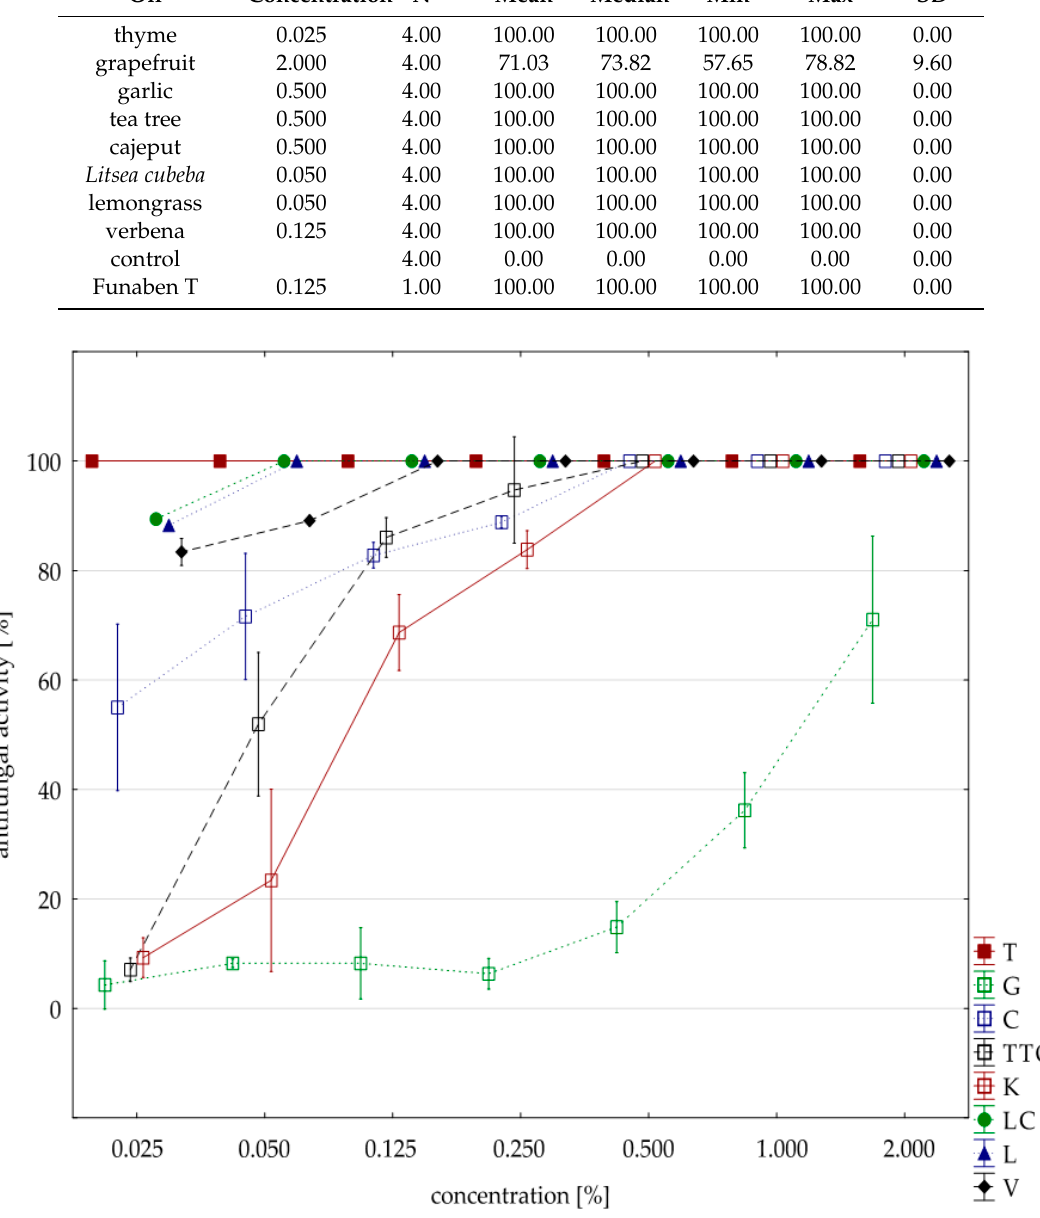
Figure 2. Plot of antifungal activity vs concentration for F . culmorum.